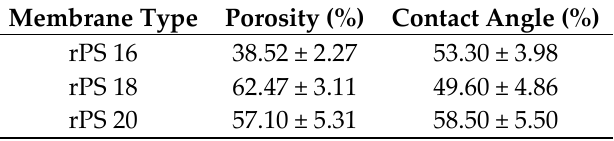
Table 1. Contribution of ingredients in the casting solution.